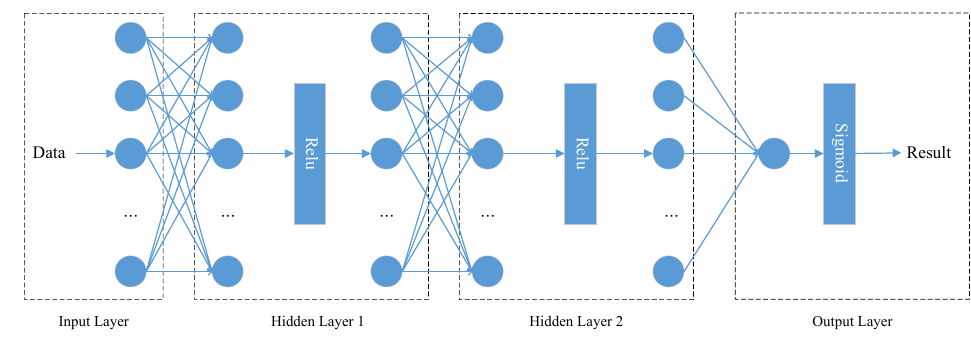
Figure 4. Structure of the PPM .